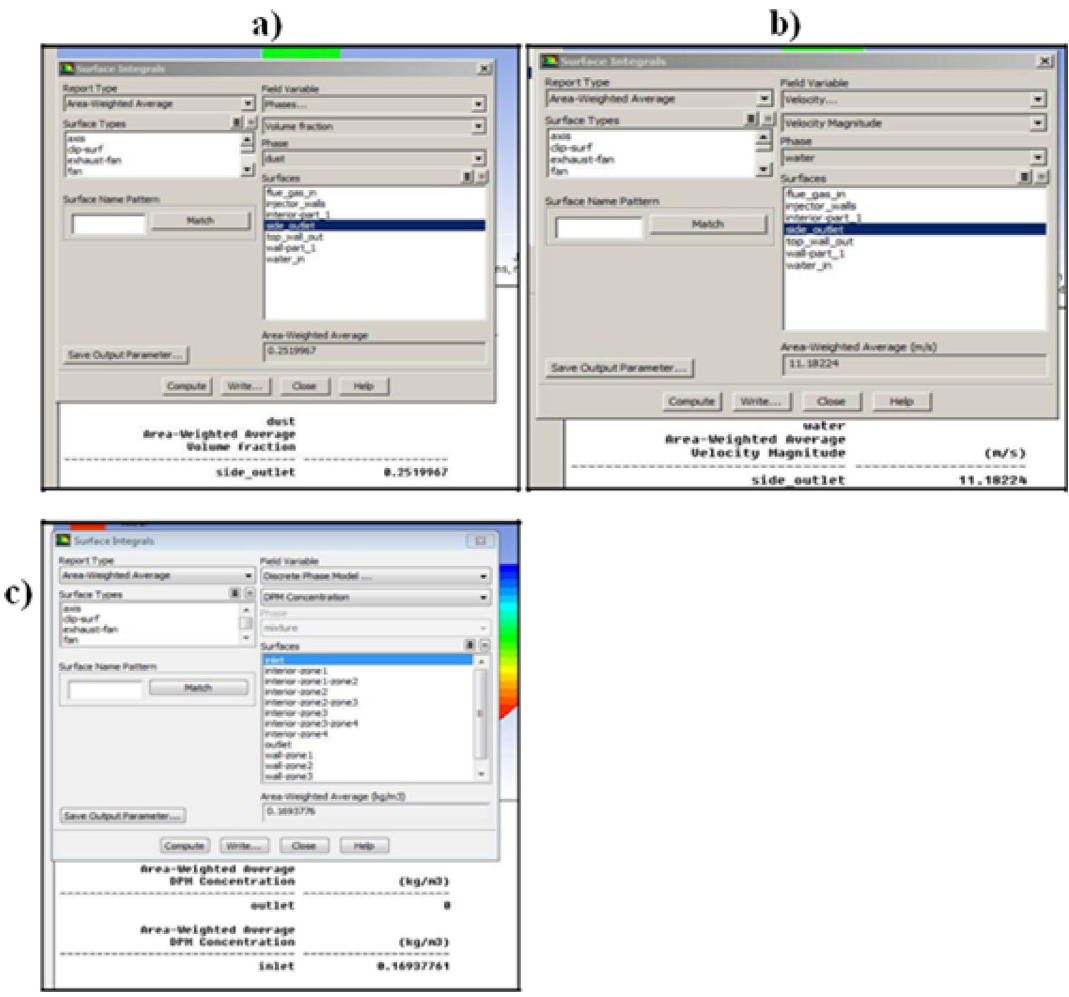
Figure 4. ( a ) Area weighted average of the volume of ( a ) fraction of dust, ( b ) flue gas, ( c ) DPM